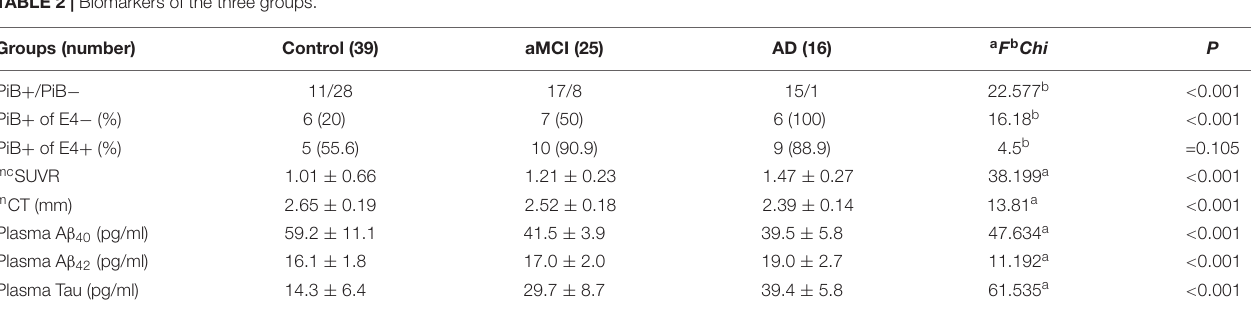
TABLE 2 | Biomarkers of the three